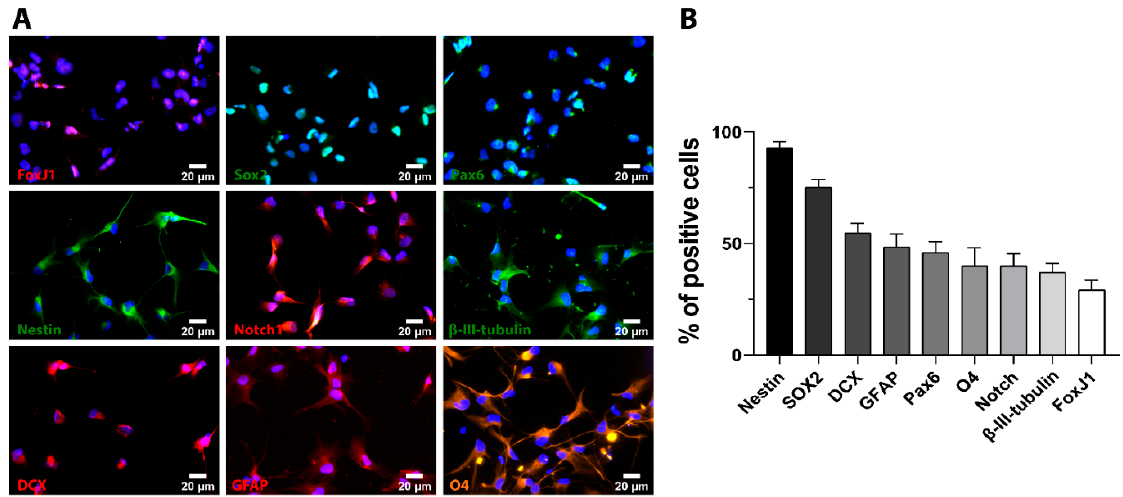
Figure 1. In vitro characterization of cultured iPSC-NSC. ( A ). Representative immunofluorescence staining images for the indicated cell markers. DAPI (blue) employed for nuclei counterstaining. Scale bar = 20 µm. ( B ). Quantitative analysis of the percentage of positive cells for each cell marker. Data expressed as mean ± S.E.M. from three independent cell culture experiments.